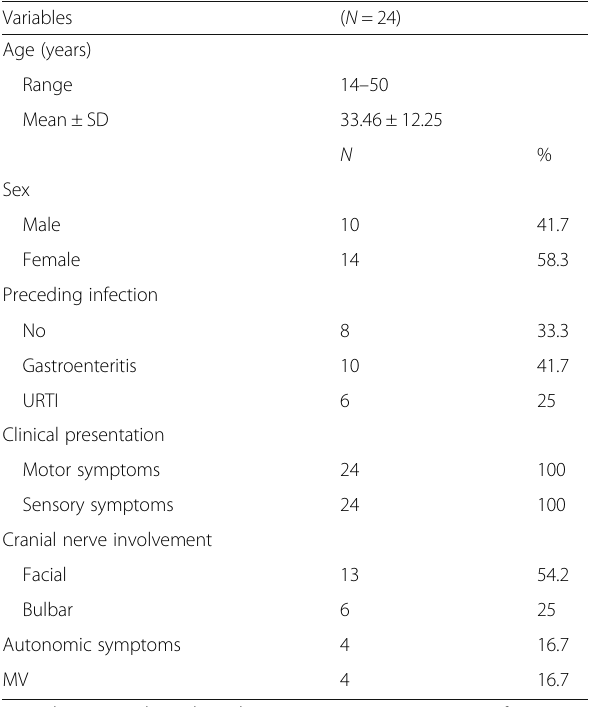
Table 1 Demographic data and clinical presentation in the studied GBS cases